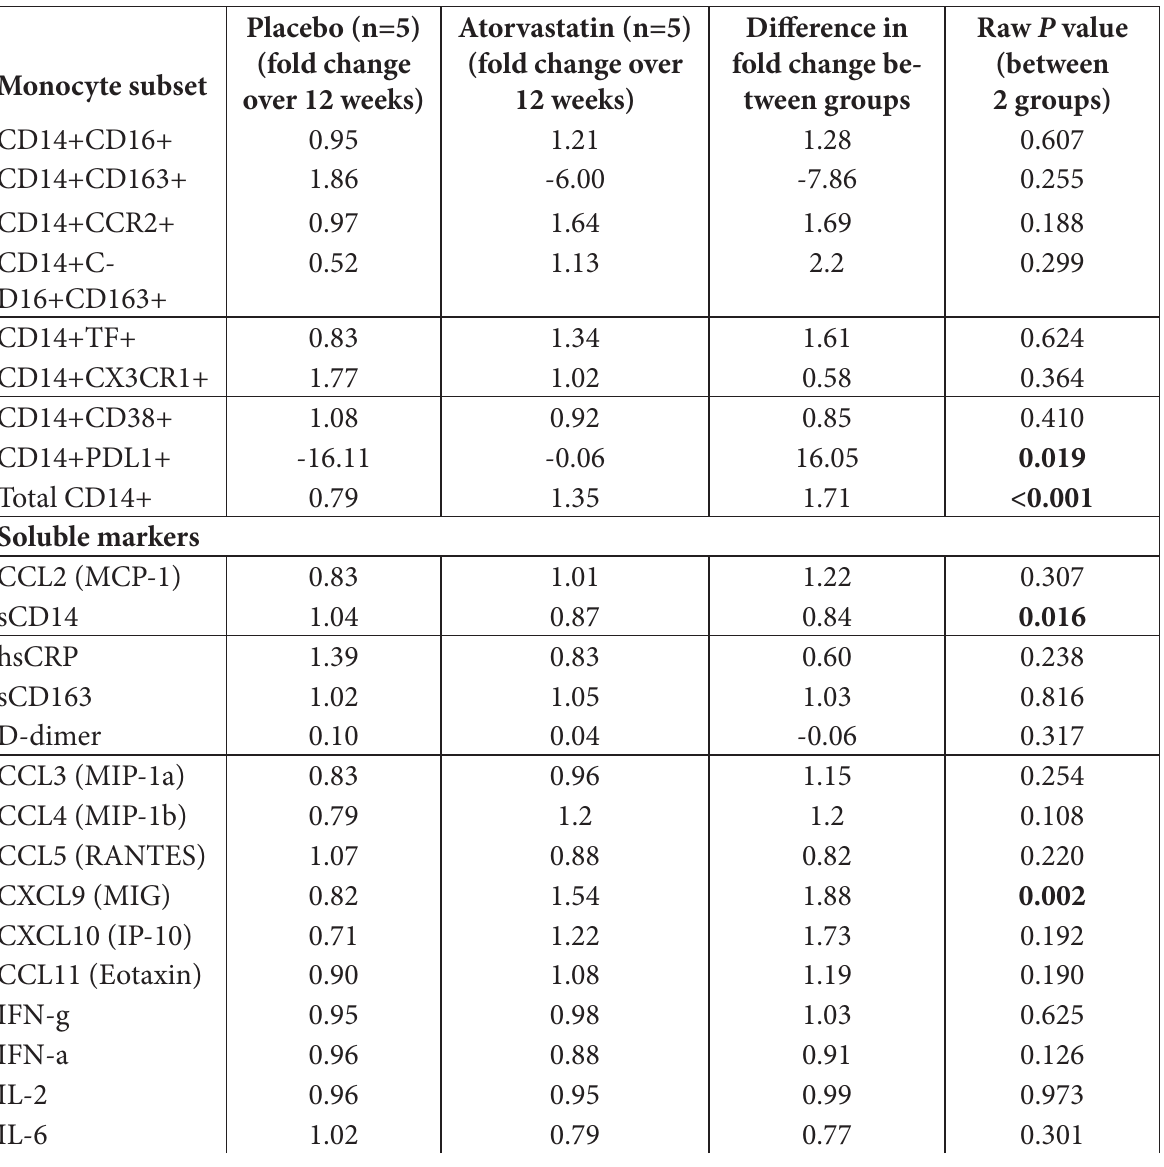
Table 4. Effect of atorvastatin in a subset of participants identified as plasma marker outliers at